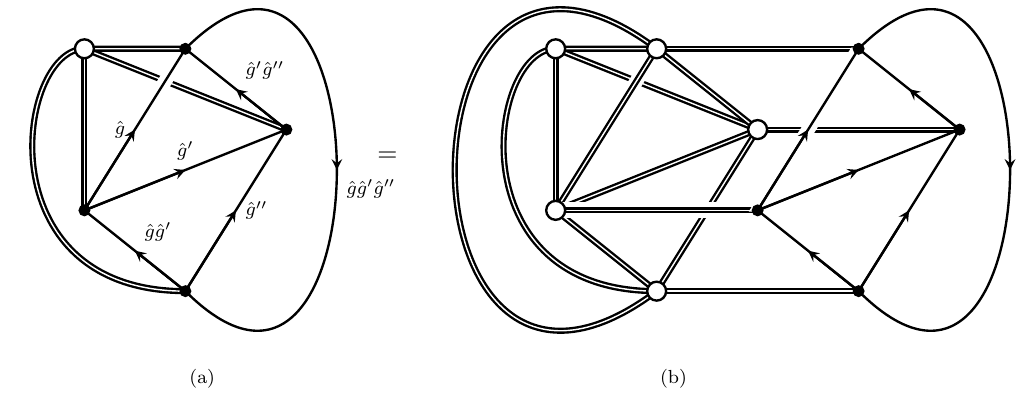
Figure 29 . The graph on the right can be obtained from graph on the left after gauge (cid:12)xing and deforming the (cid:5)